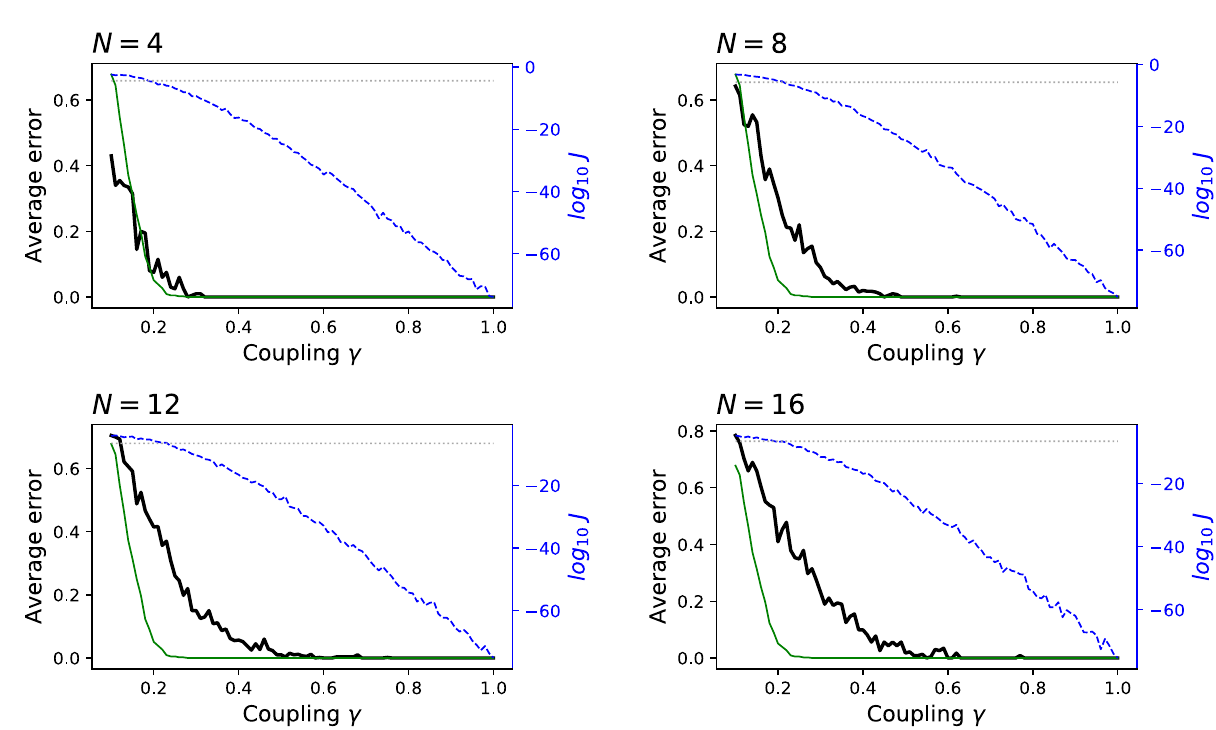
Figure 2. Significance of the clustering for synthetic data and C = 2 . Each panel reports, for different values of N and as a function of the coupling γ : the average error of the best clustering, compared with the real cluster assignation (black lines, left axes); fraction of times the Granger causality test fails to detect a statistically significant result (green lines, left axes); average of the log 10 J of the solution (blue dashed lines, right axes); and average J obtained for uncorrelated time series (grey dotted horizontal lines, right axes). See main text for details on the reconstruction of the synthetic